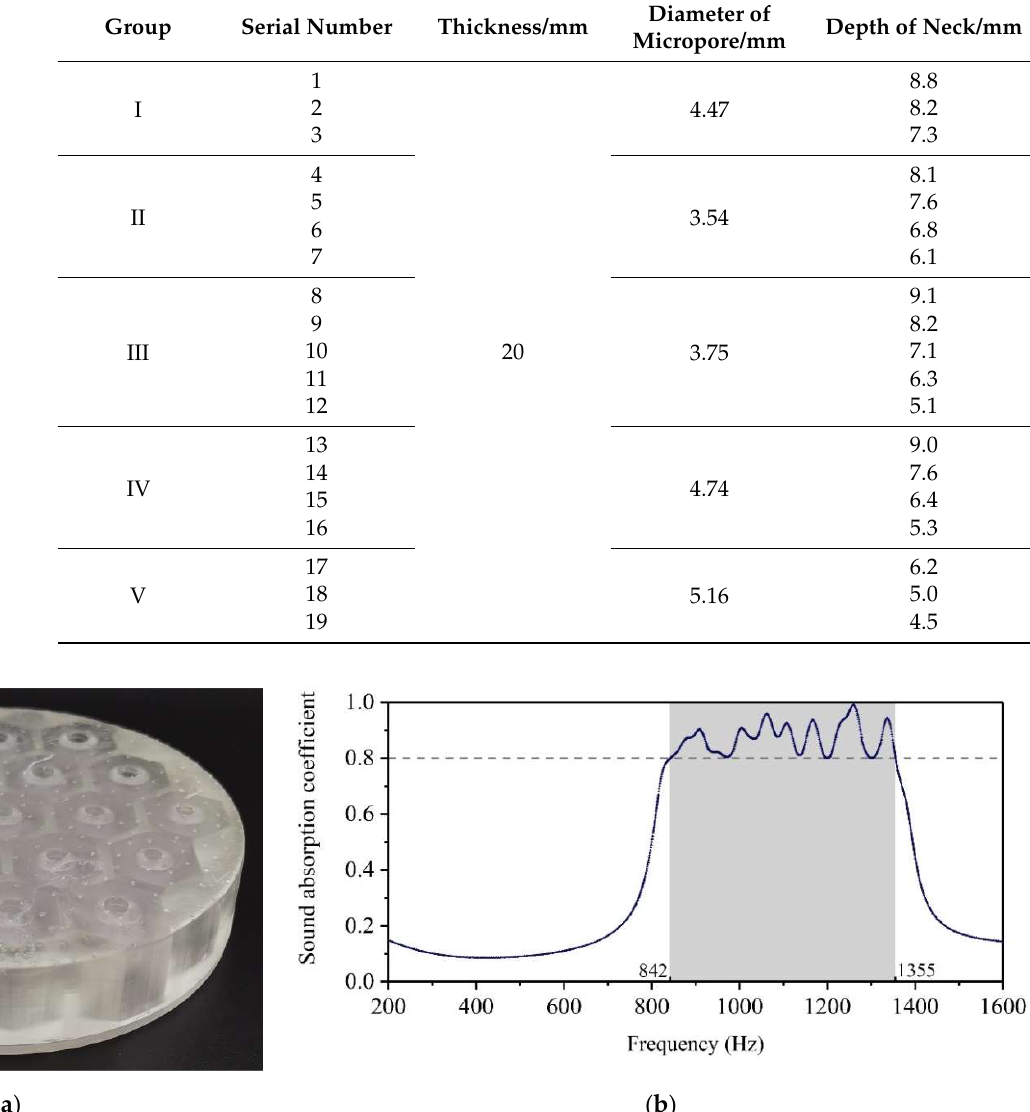
Table 3. The optimized geometric parameters for design requirements of Condition-1.